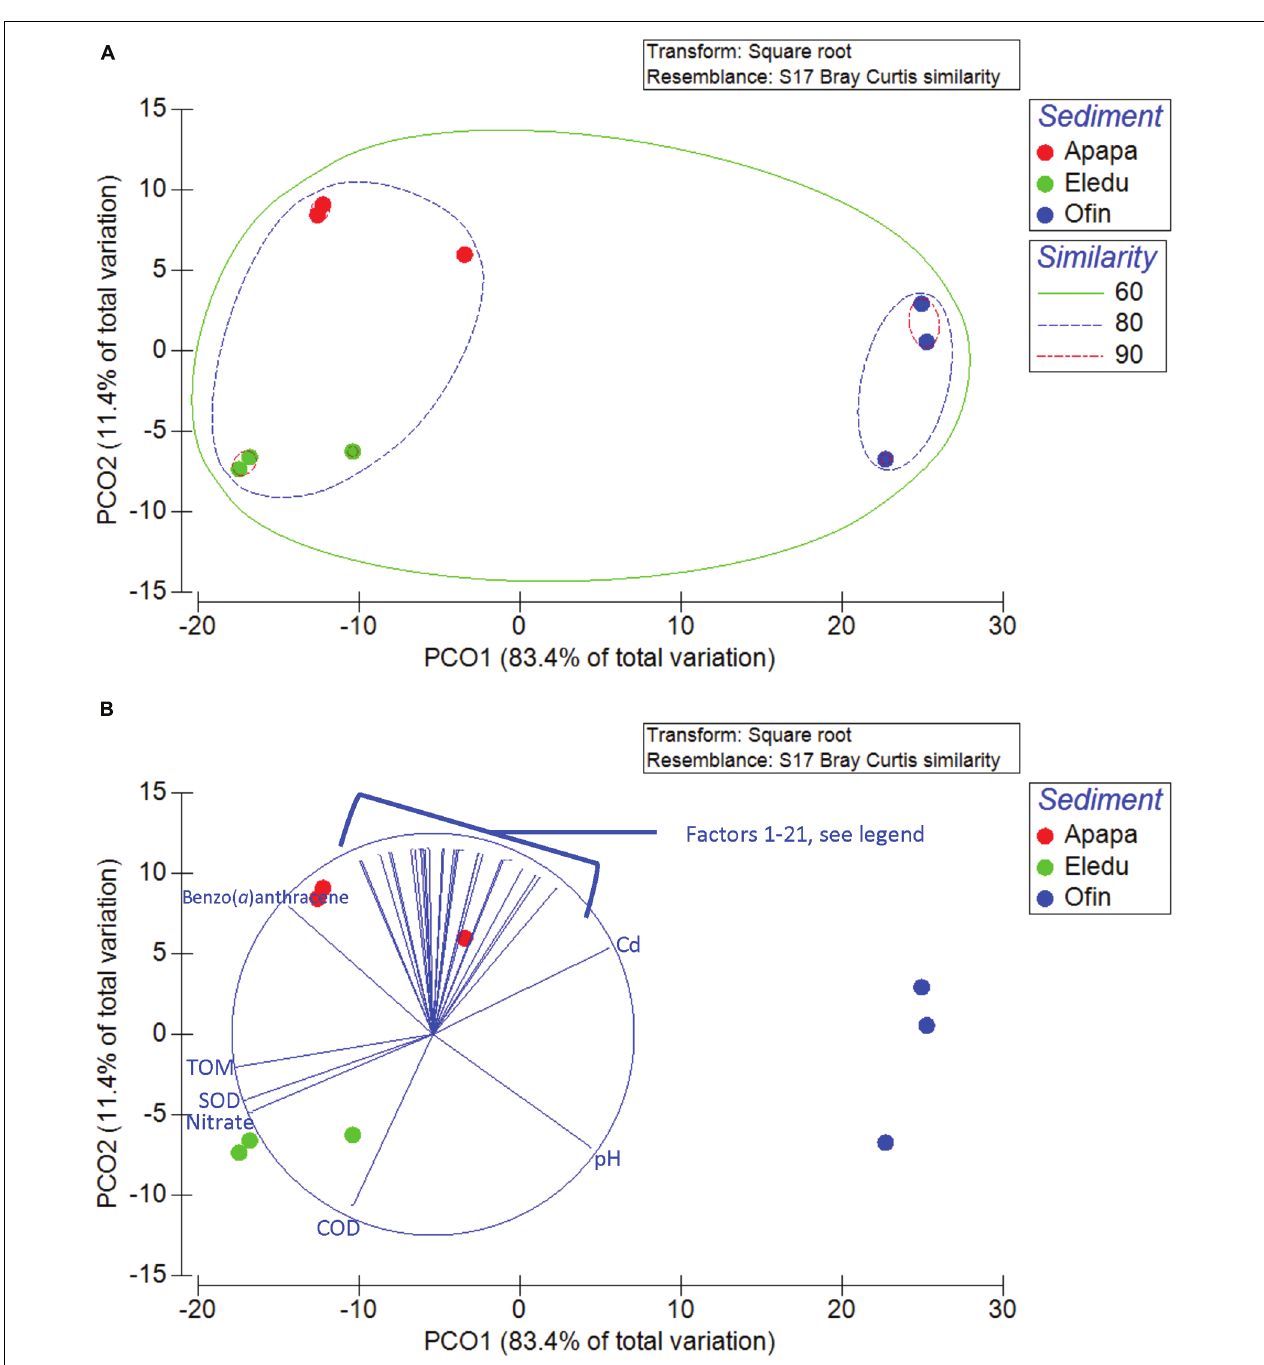
FIGURE 3 | Principal component ordinations of the sediment microbial communities showing levels of similarity among sampling sites (A) and environmental variables associated with the segregation of communities along the PCO axes (B). Environmental variables contained within the brackets are (left to right in the cluster): 1. Pb, 2. Benzo( a )pyrene, 3. Benzo( b )fluoranthene, 4. Benzo( g,h,i )perylene, 5. Cr, 6. Acenaphthene, 7. Cu, 8. Acenaphthylene, 9. Anthracene, 10. Benzo( k )fluoranthene, 11. Naphthalene, 12. Phenanthrene, 13. Indeno(1,2,3- c,d )pyrene, 14. Pyrene, 15. Chrysene, 16. Ni, 17. Dibenzo( a,h )anthracene, 18. Fluoranthene, 19. Fluorene, 20. Pyrene, 21. Co.